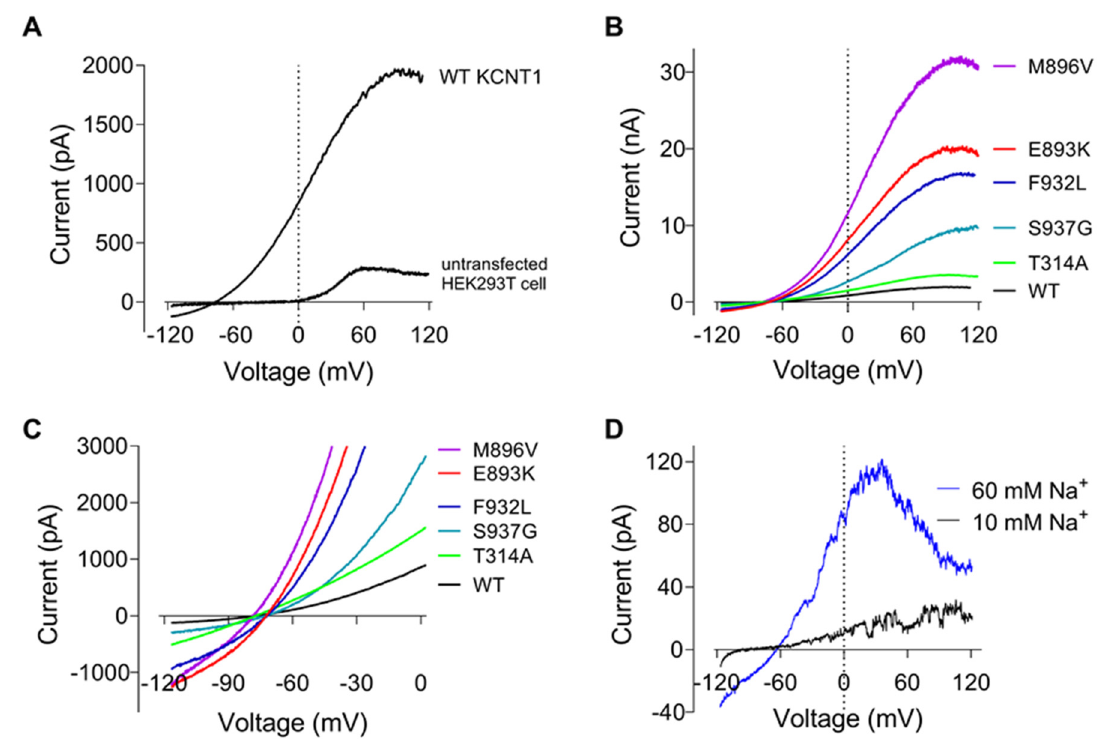
Figure 1. Current-voltage plots of WT and mutant KCNT1 channels expressed in HEK293T cells. ( A ) I-V plots recorded in response to 100 ms ramps ranging from − 120 to 120 mV in a cell transfected with WT KCNT1 and an untransfected cell. ( B ). Representative I-V plots of KCNT1 channels carrying GoF mutations. ( C ). The same data as on panel B, shown at a different scale. ( D ). WT KCNT1 currents recorded in inside-out patch in the presence of 10 mM or 60 mM intracellular Na +